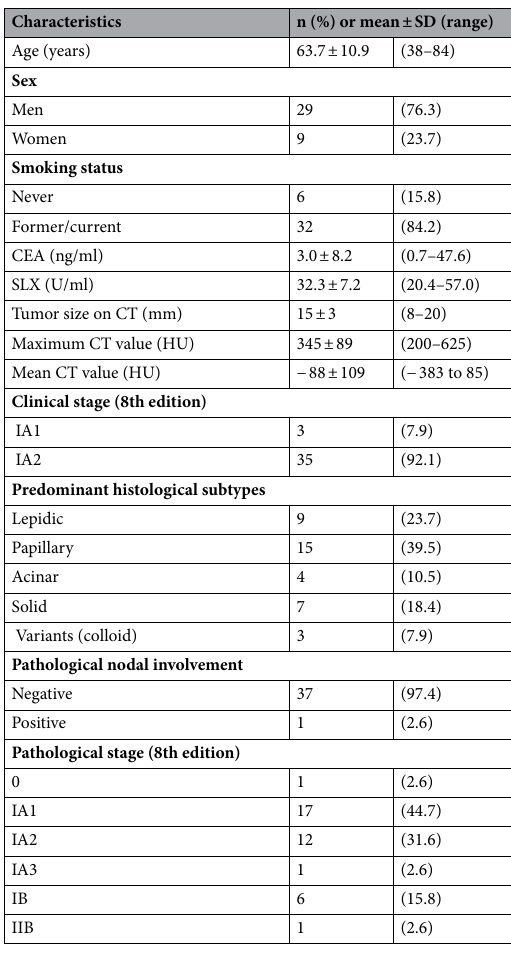
Table 1. Clinical, radiological, and histological characteristics. Categorical variables are shown as numbers (%). Continuous variables are presented as mean ± SD (range). CEA carcinoembryonic antigen, SLX sialyl Lewis